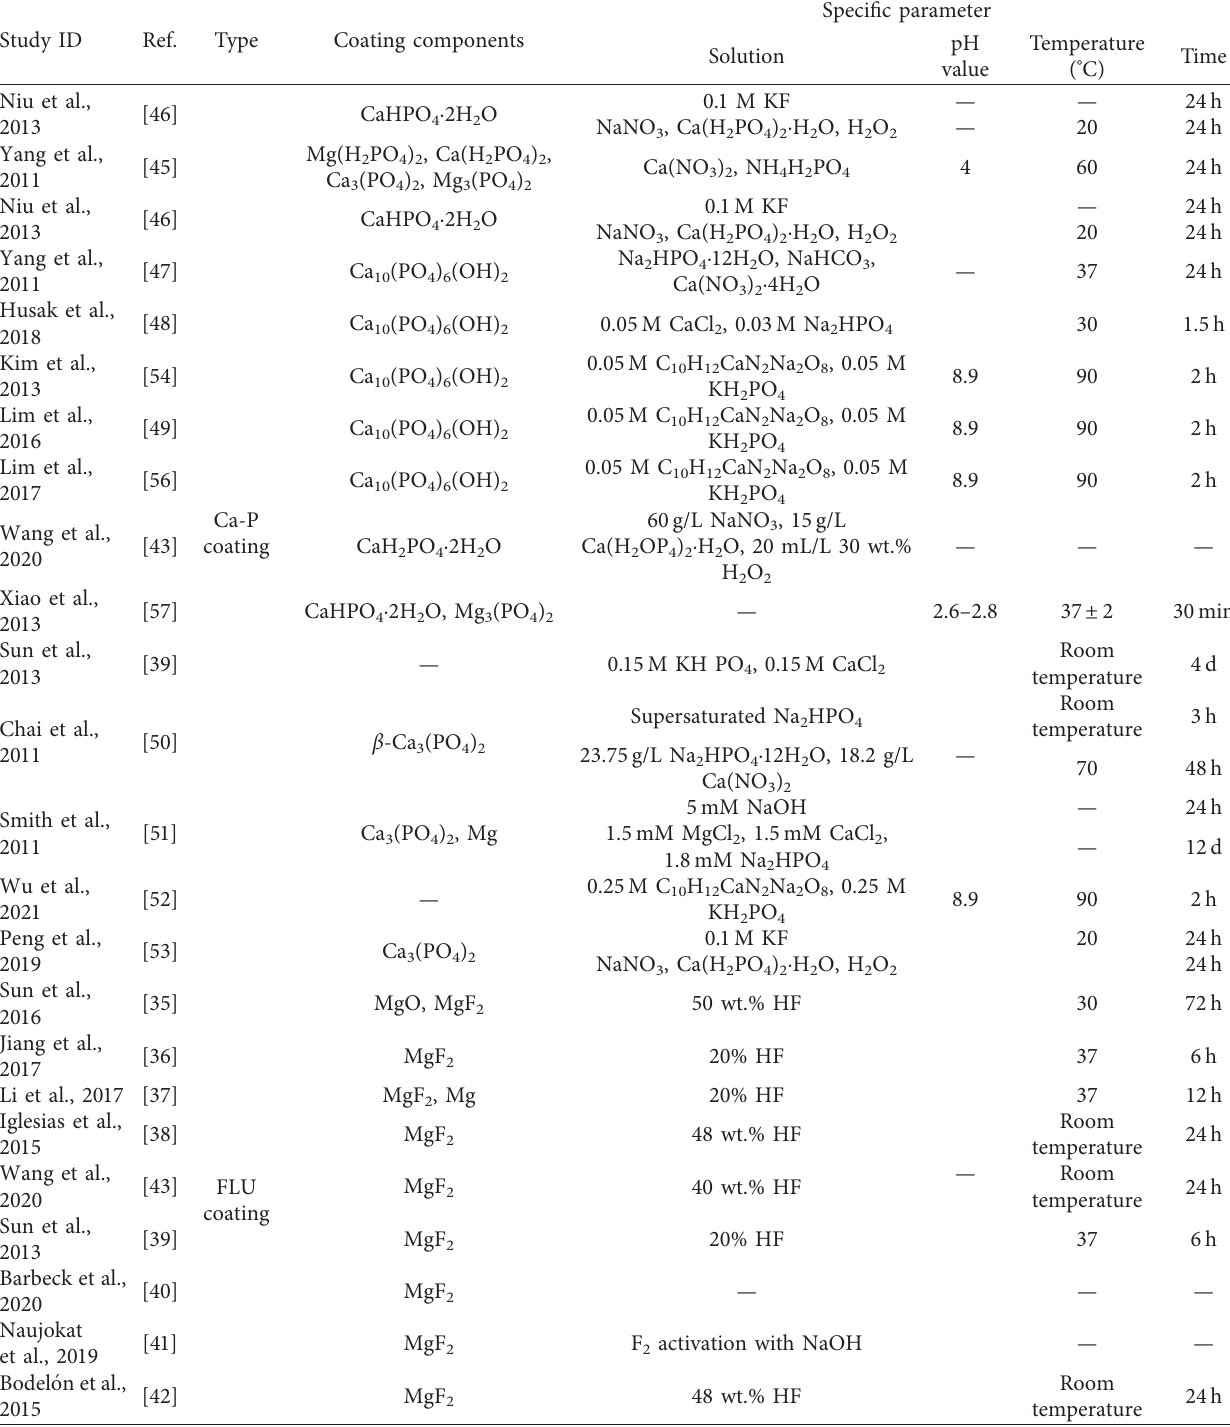
Table 5: Ca-P and FLU treatment manufacturing